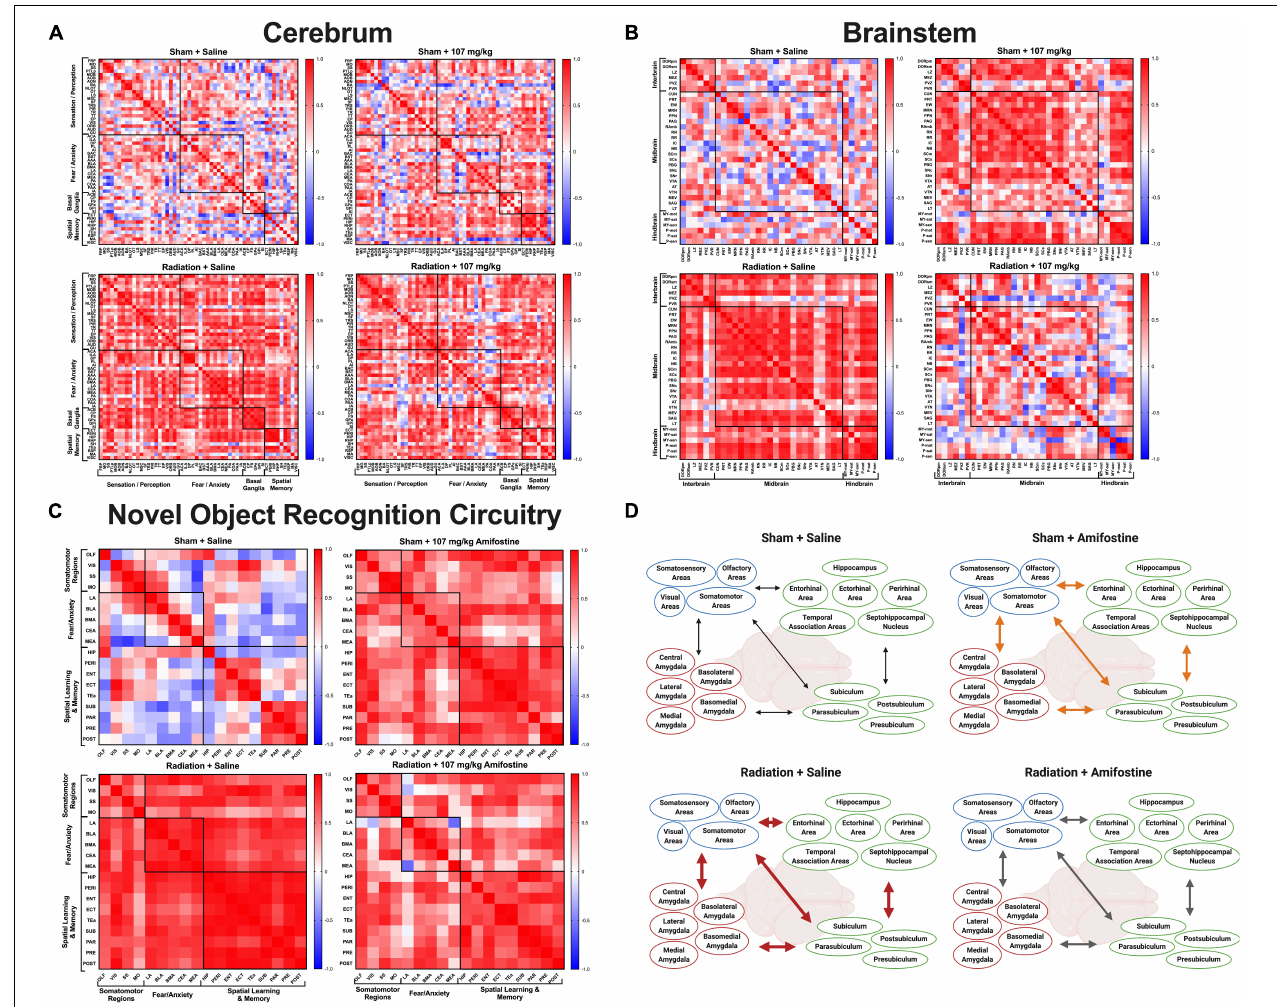
FIGURE 4 | Whole brain cFos data. Pearson’s correlations were run for all regions in each distinct group: Sham-Saline ( top left ), Sham-107 mg/kg ( top right ), Rad-Saline ( bottom left ), and Rad-107 mg/kg ( bottom right ). Bonferroni correction was applied to comparisons of the correlation matrices. (A) cFos connectivity in the cerebrum. All groups were significantly different from each other. (B) cFos connectivity in the brainstem. All groups were significantly different from each other. (C) cFos connectivity in regions important for 24 h novel object recognition. Most groups were significantly different from each other. No difference was detected between Sham-107 mg/kg and Rad-Saline ( p = 0.0912). Full names for brain regions can be seen in Supplementary Tables 2 , 3 . (D) Schematic depicting the changes in co-activation of brain regions important for novel object recognition. Both radiation and amifostine increased the correlations between brain regions. Radiation appeared to cause strong, positive correlations across all brain regions (depicted by thick, red arrows); amifostine appeared to do the same, albeit to a lesser extent (depicted by thick, orange arrows). Radiation +107 mg/kg amifostine somewhat ameliorated the strong, positive correlations induced by radiation, though the correlations were still stronger than the Sham-Saline group (depicted by medium, gray arrows). Created with